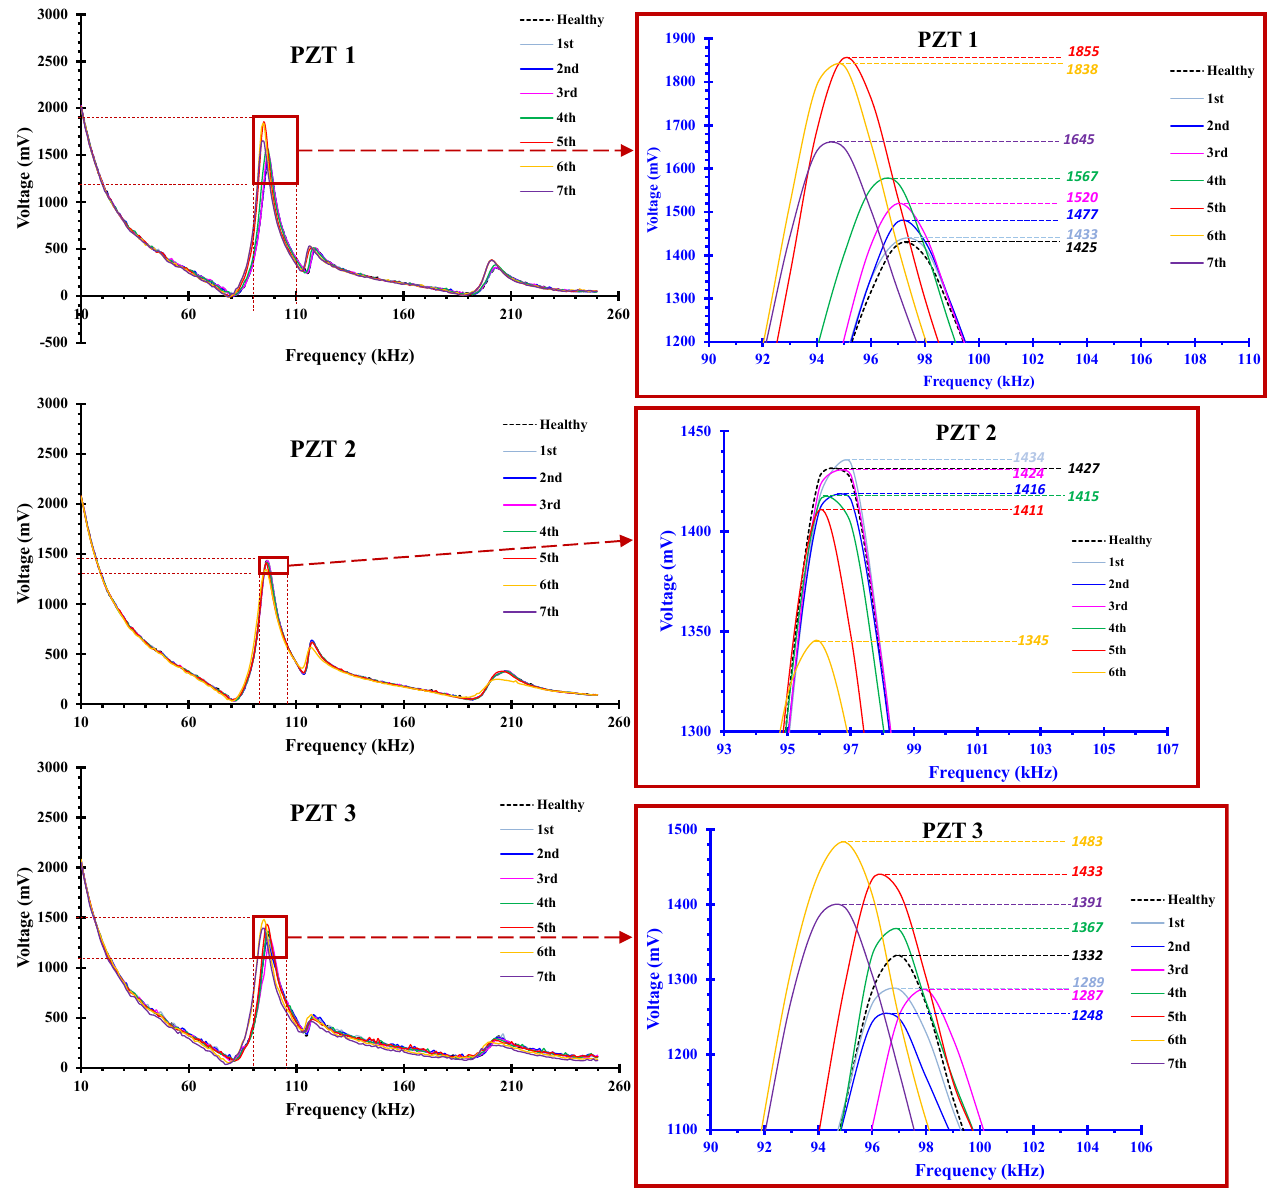
Figure 13. Frequency response of PZT transducers attached to the concrete surface in the direction of the joint panel diagonal of specimen JC0. Each curve represents the voltage versus frequency of the PZT at the end of each loading step (unloaded condition).